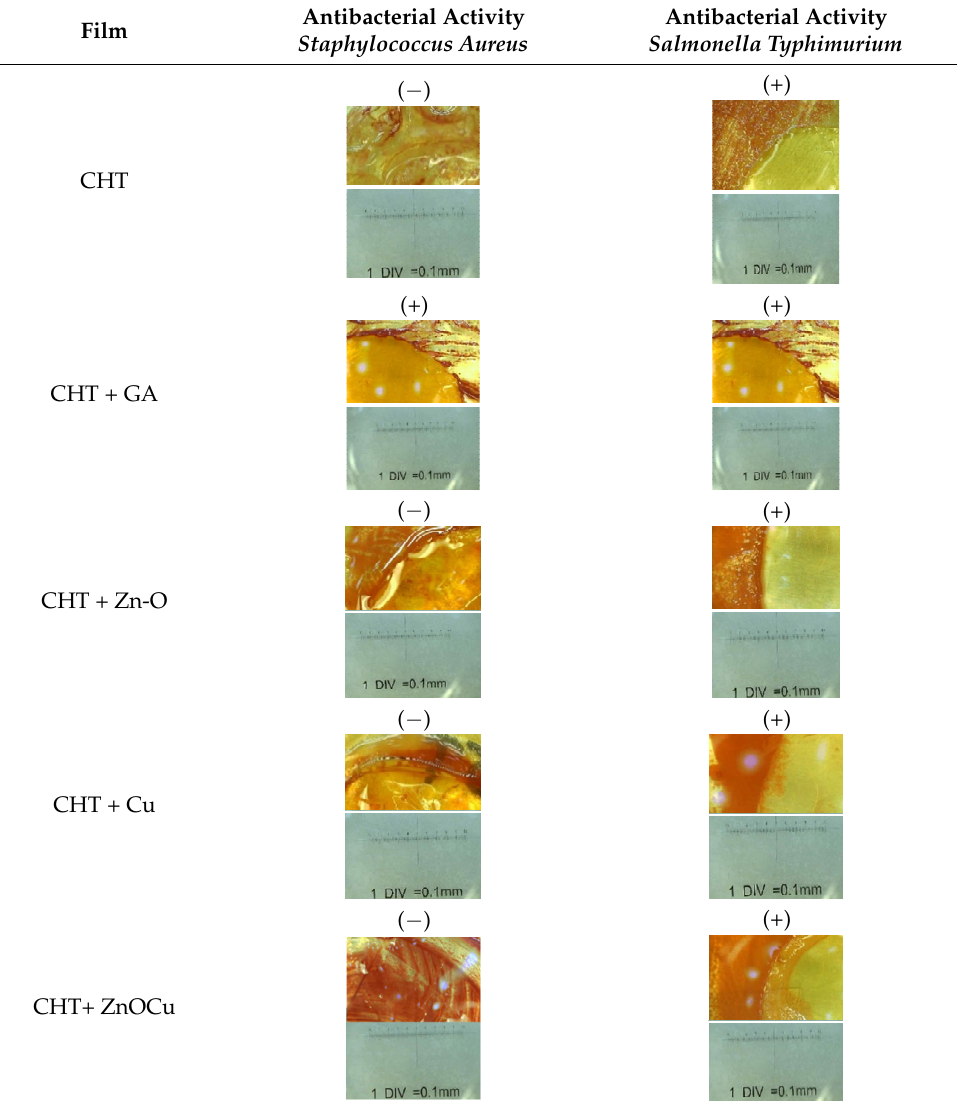
Table 5. Antimicrobial activity: positive (+) and negative ( − ) against Staphylococcus aureus and S. tiphimurium of chitosan discs; before 24 h (top) and after 24 h (bottom) of inoculation.